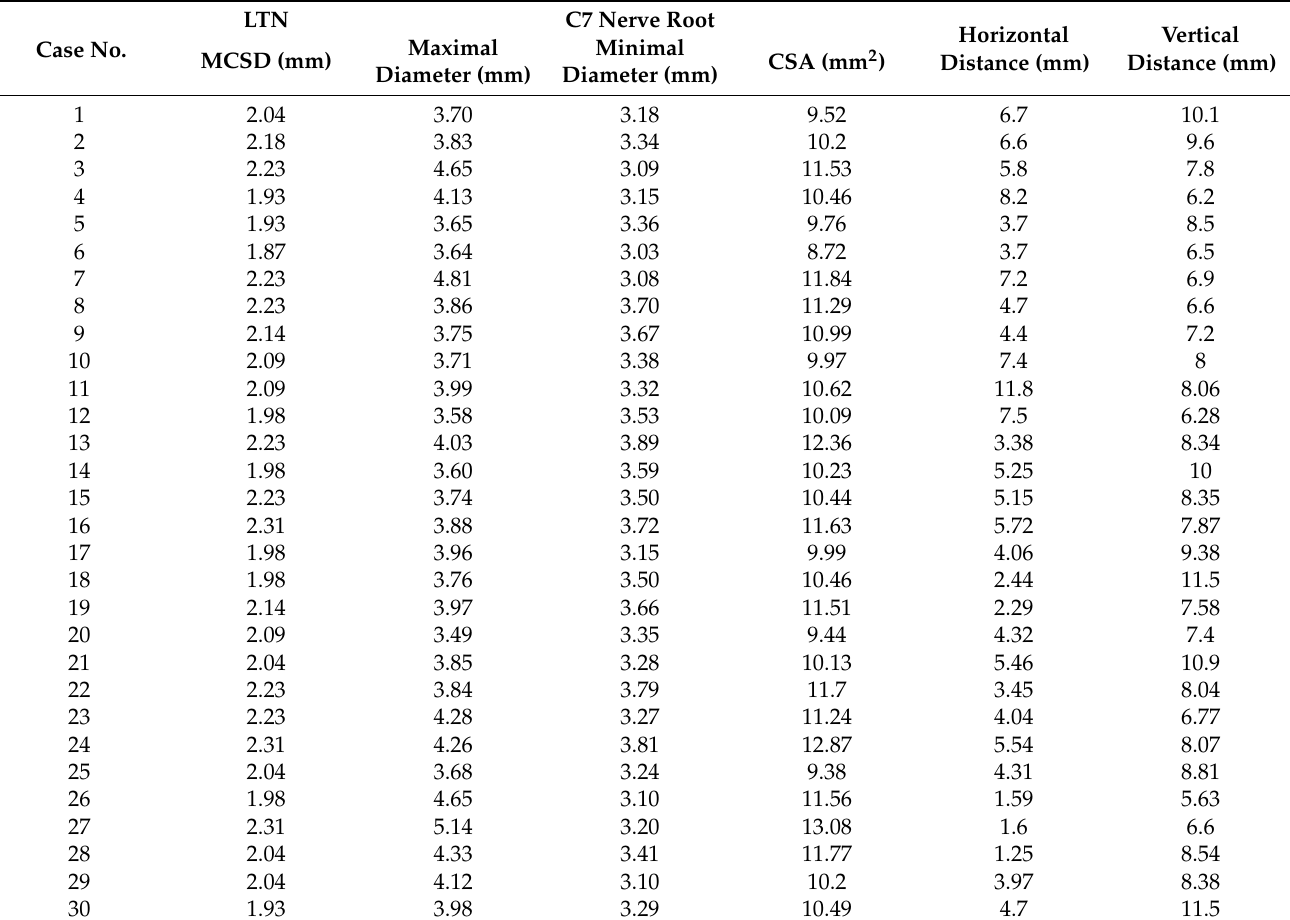
Table 2. Measurement data of the long thoracic nerve (LTN) and C7 nerve root.